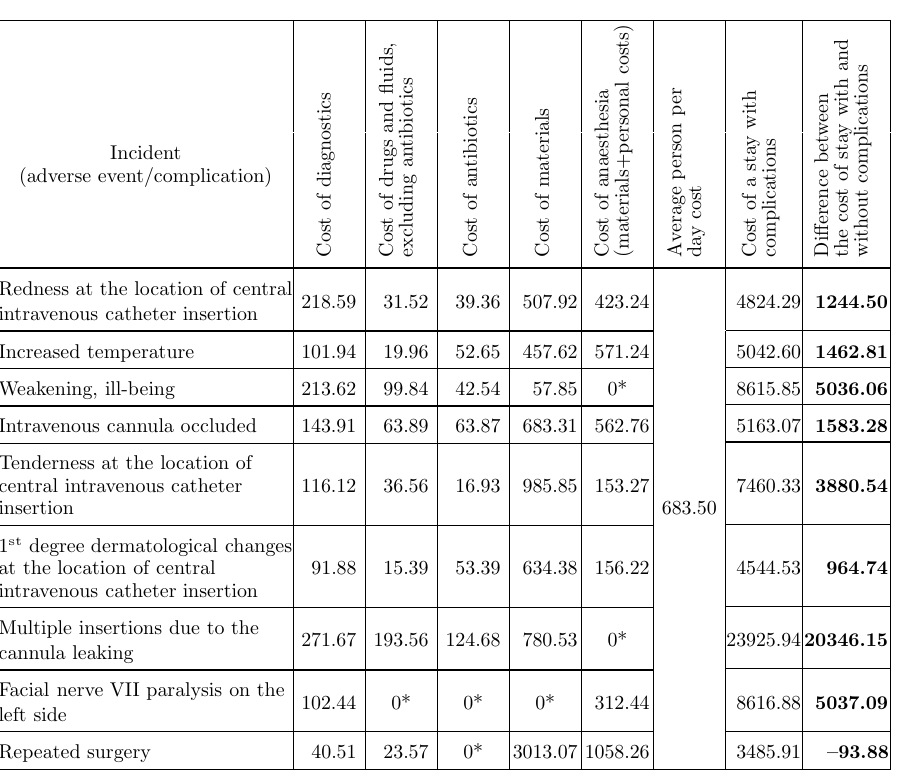
Table 5. Detailed analysis of C22 hospitalisation costs with complications